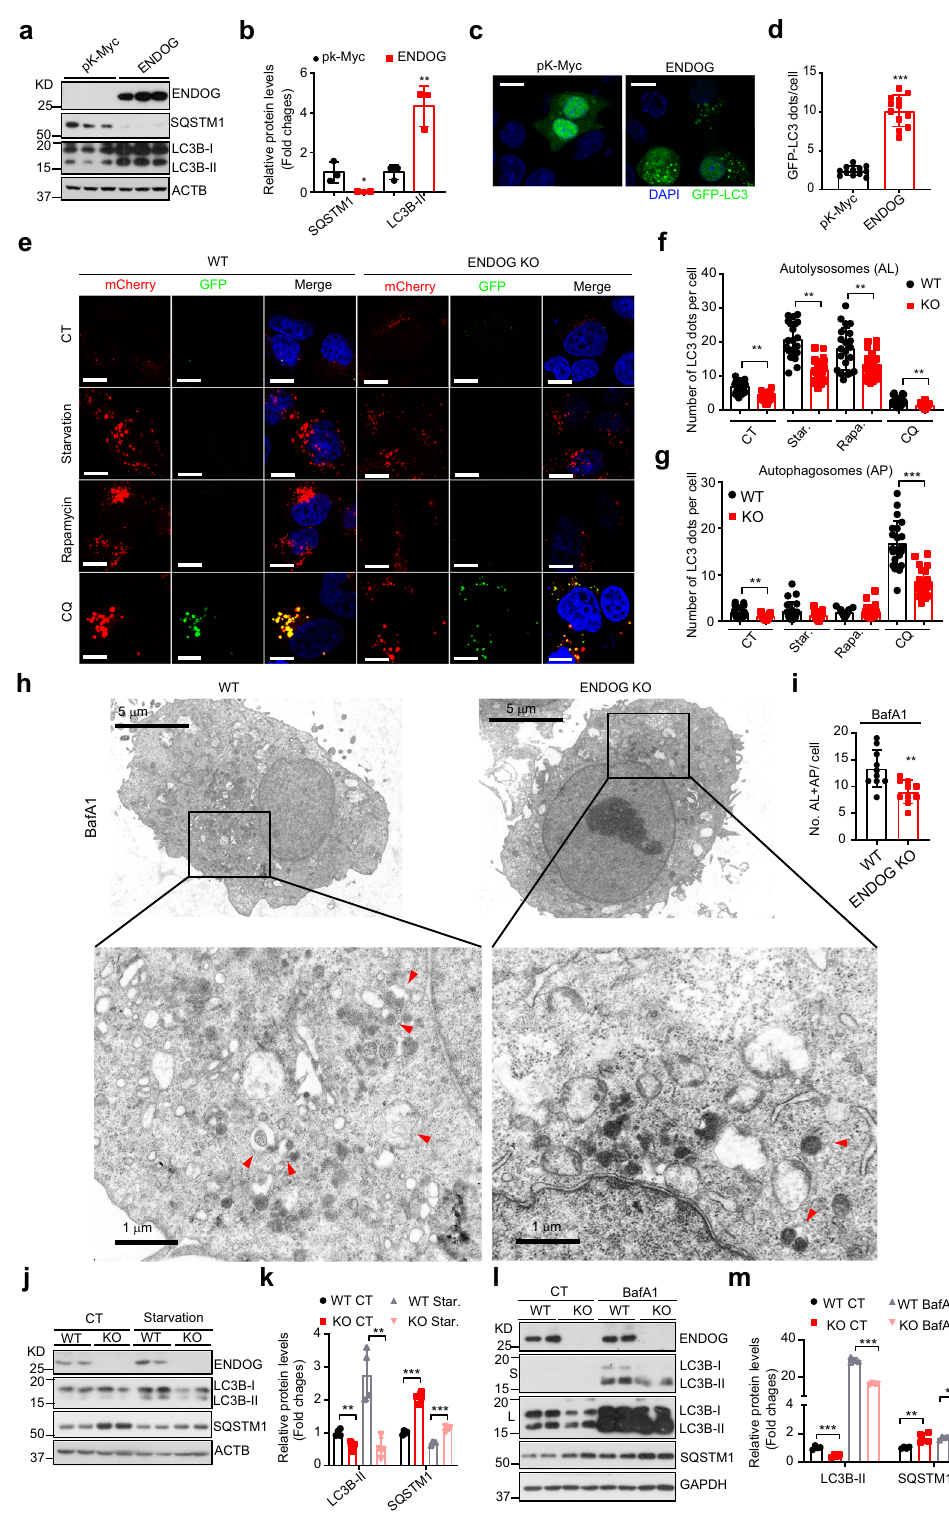
substrates (p70S6K-Thr389, ULK1-Ser757, and 4EBP1-Thr37/46) (Fig. 3a, b). Consistently, in other hepatoma cell lines, knockdown of ENDOG increased phosphorylation of mTOR and ULK1, as well as suppressed autophagy under starvation (Supplementary Fig. 4b – e). In vivo, compared to that in the Endog + / − mouse livers, the phosphorylation of mTOR-Ser2448, ULK1-Ser757, and 4EBP1-Thr37/46 were signi fi cantly increased in Endog − / − mouse NATURE COMMUNICATIONS| (2021) 12:476